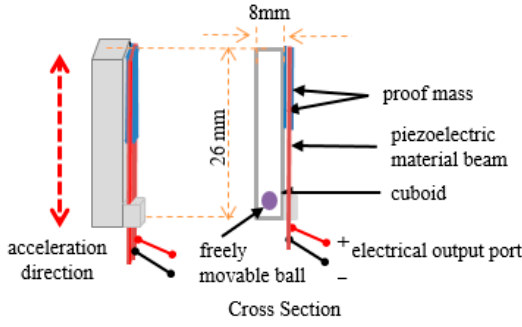
Figure 1. Diagram of the used frequency-up-converting impact-based piezoelectric energy harvester.